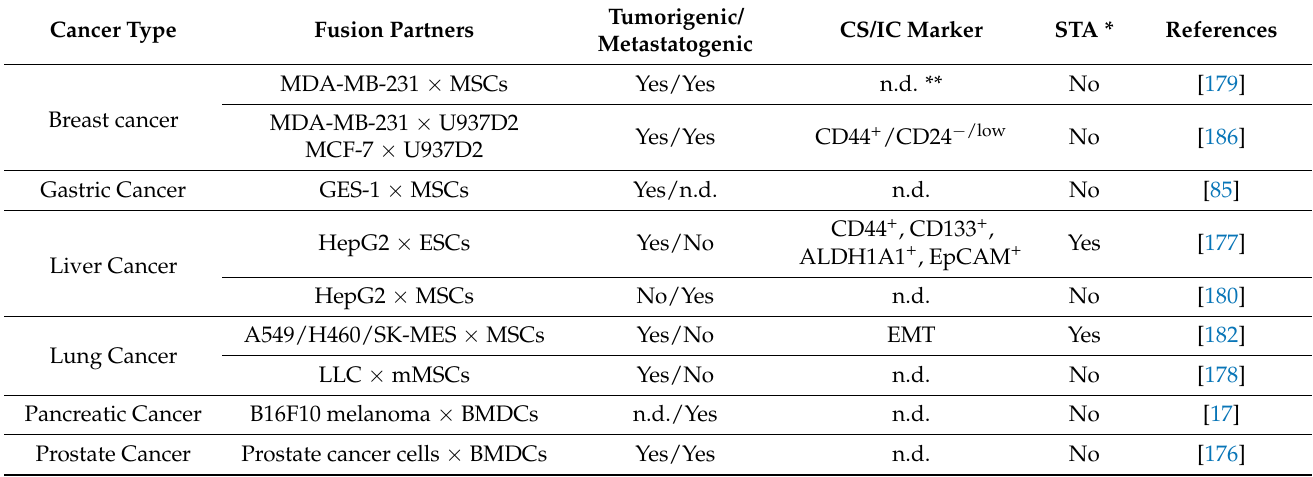
Table 2. In vitro cell–cell-fusion-derived tumor hybrids with prospective CS/IC